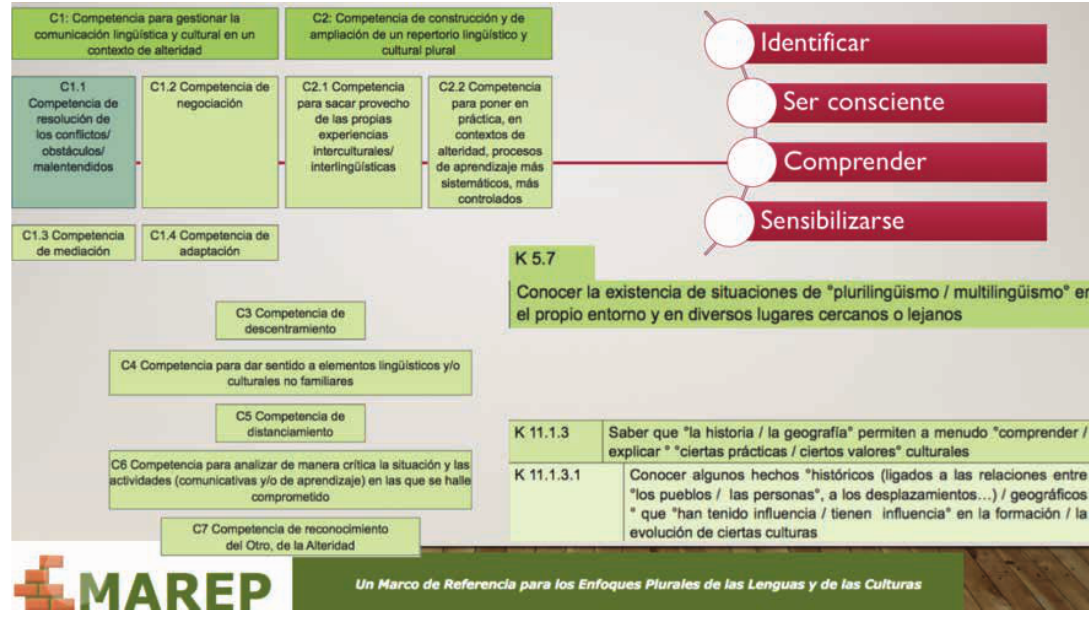
Figure 4: Proposal for organising learning according to